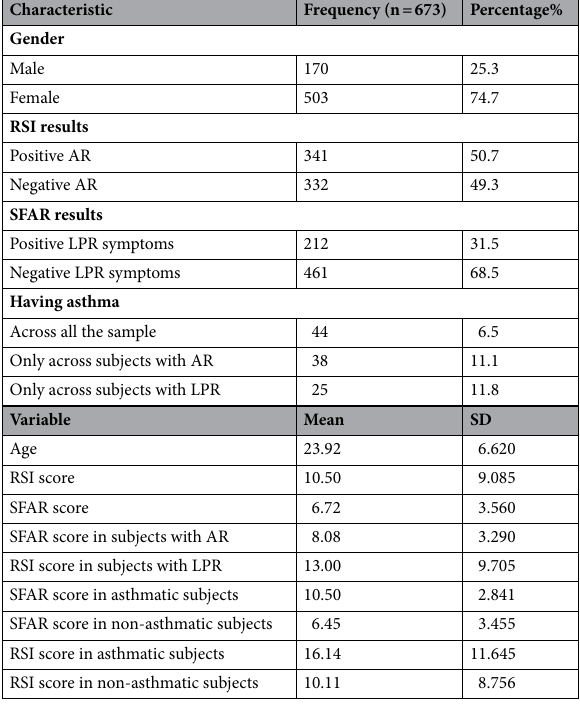
Table 1. Characteristics of subjects, their demographic data, and RSI and SFAR results and scores. SFAR: score for allergic rhinitis; RSI: reflux symptom index; LPR: laryngopharyngeal reflux; AR: allergic rhinitis; SD: standard deviation.